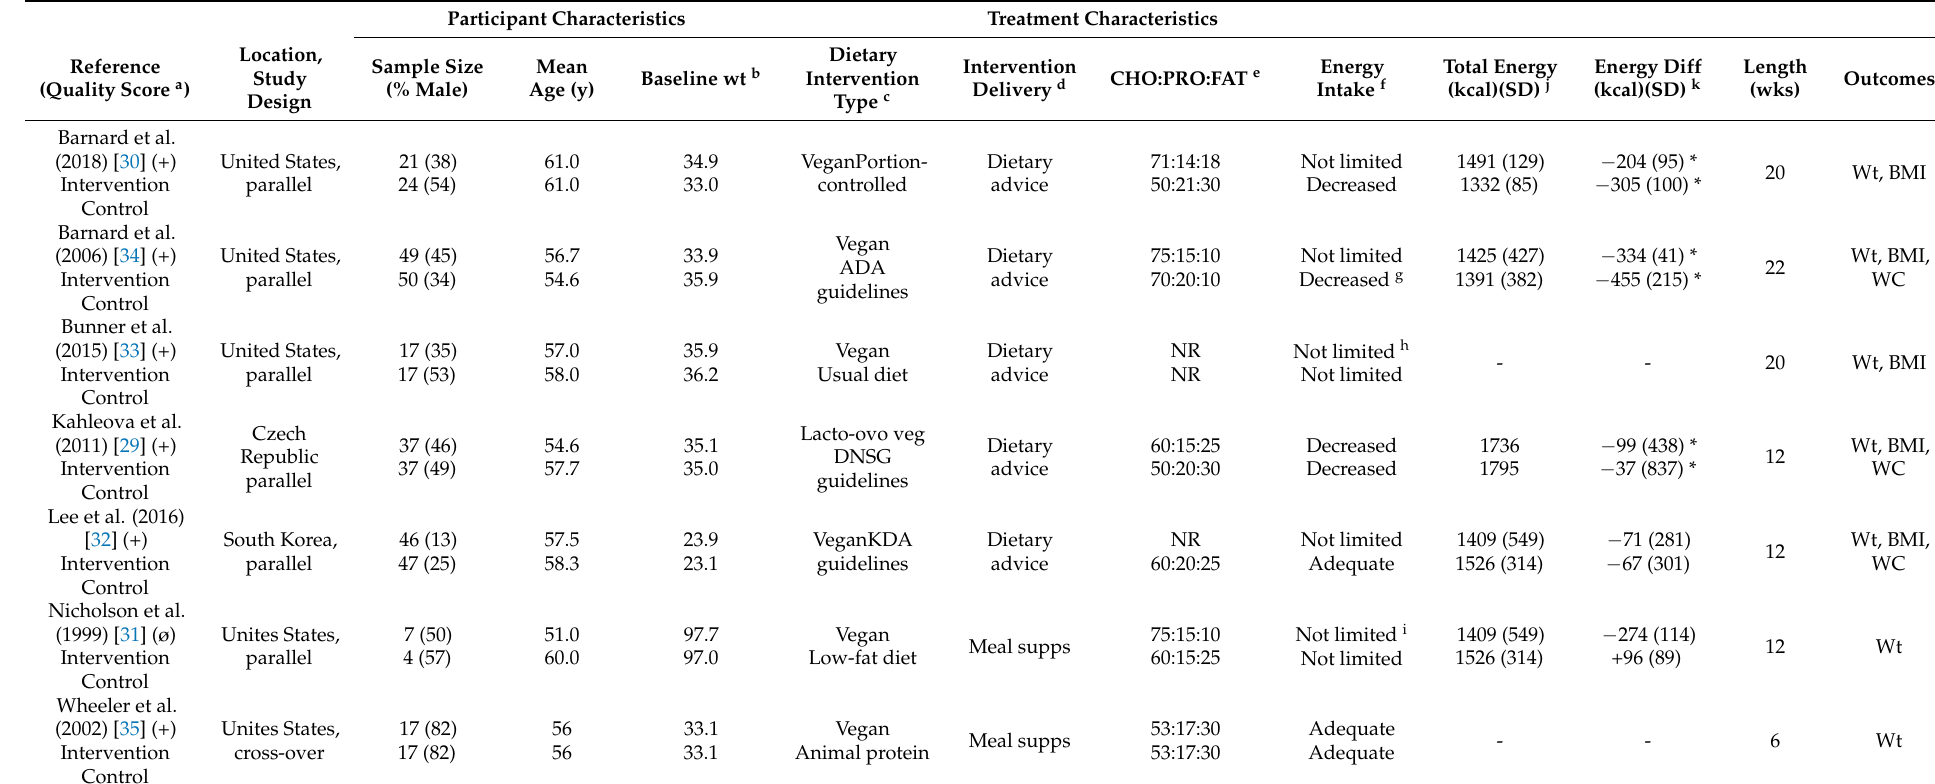
Table 2. Overview of publications included in the systematic review ( n =